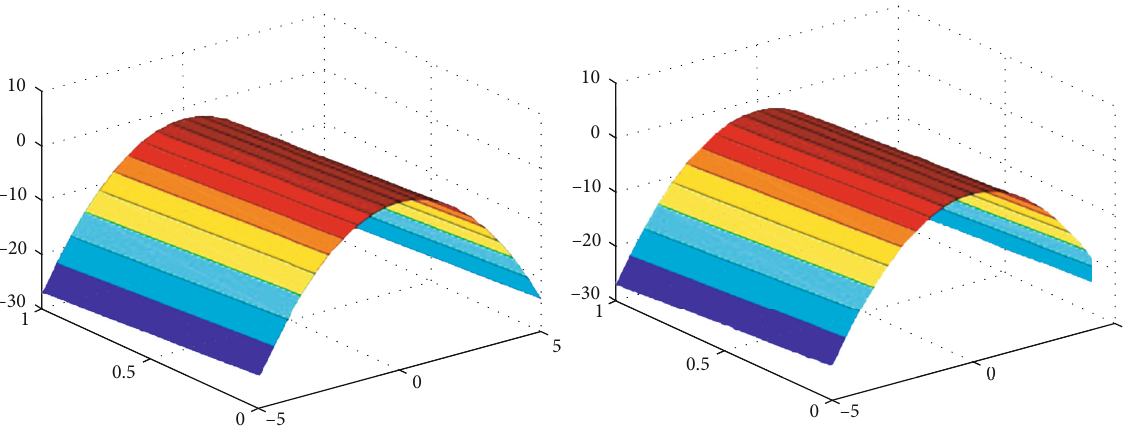
Figure 1: Graph of exact and analytical results of Problem 1.